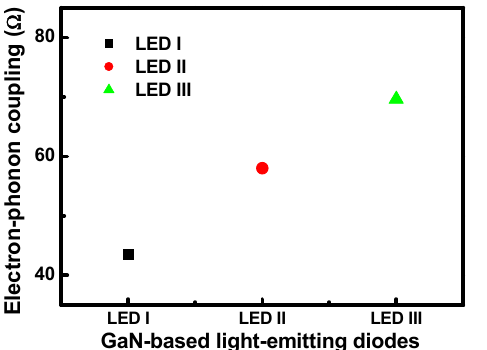
Figure 6. The electron–phonon coupling coefficients as a function of the LED structures for samples LED I, LED II, and LED III.